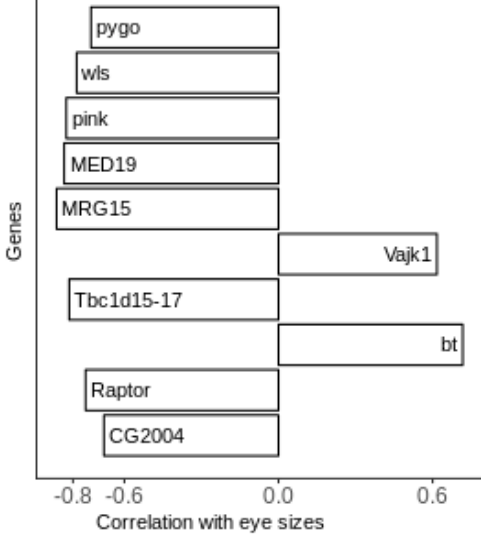
Figure 3. Top candidate genes and their correlation values.